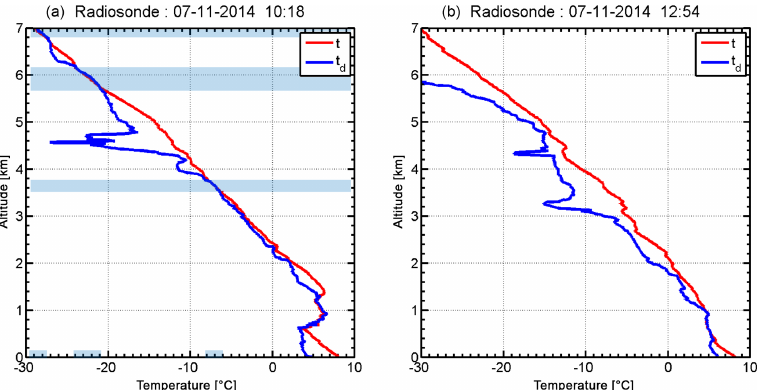
Figure 9. Radiosonde launches from the CESAR site at 10:18UTC (a) and after precipitation system has passed at 12:54UTC (b) . Displayed are profiles of the temperature t (red) and dew-point temperature t d (blue). The light blue bars indicate areas where supercooled liquid water was detected with the radiosondes; their corresponding temperature range on the x -axis is